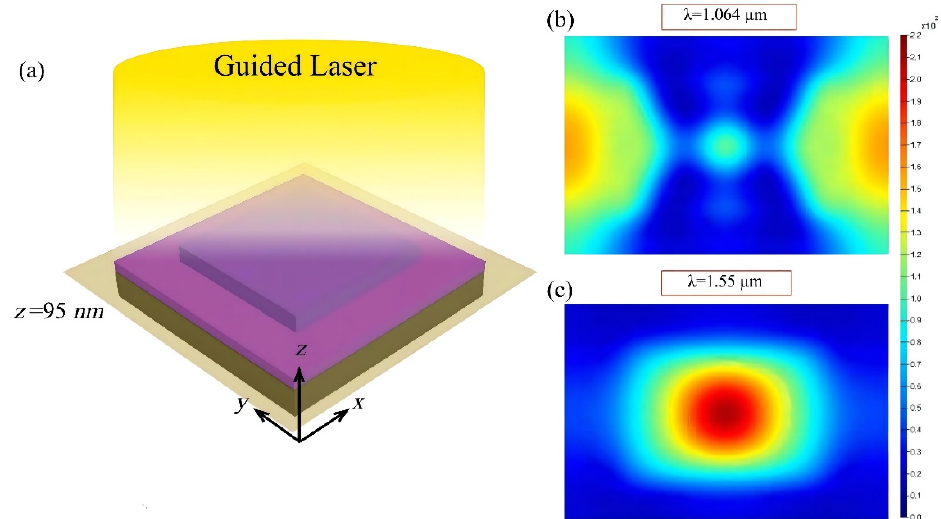
Figure 5. Simulated energy loss at the 1.064 μ m and 1.55 μ m wavelengths. ( a ) Position of the investigated cross-section. ( b , c ) Energy losses at wavelengths of 1.064 μ m and 1.55 μ m, respectively. The distance between the cross-section and the bottom surface of the nickel film is 95 nm.